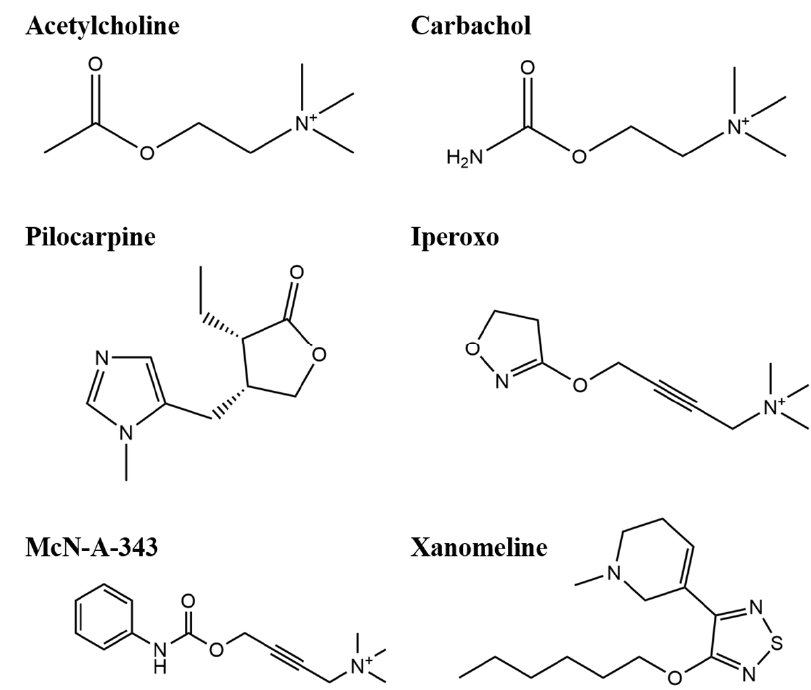
Figure 1. The 2D chemical structures of the six